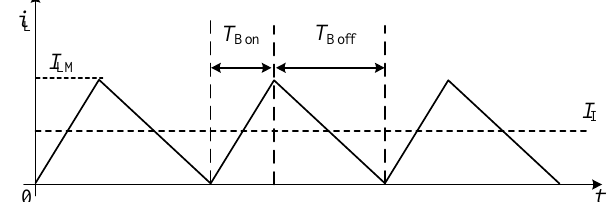
Figure 13. Current waveform of the boost circuit under critical state.